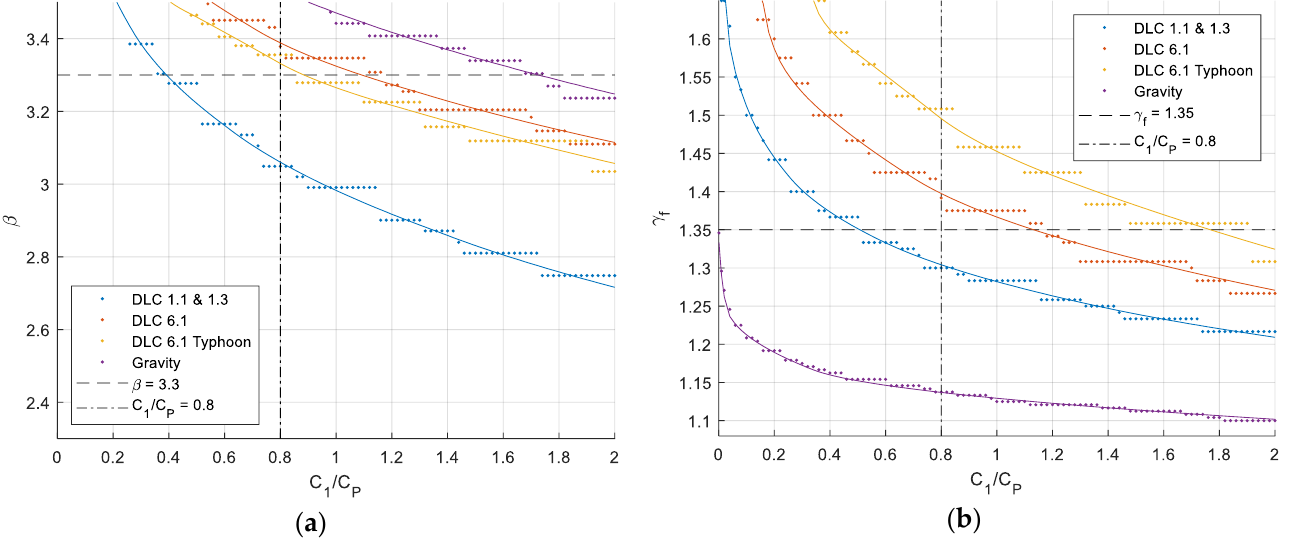
Figure 5. The optimal value of ( a ) annual reliability index (in the first year), ( b ) load safety factor for H / C 1 = 10. The dots correspond to optimal values of the design parameter among the ones where reliability analyses were performed, and the lines are obtained by using a cubic smoothing spline on the expected profit Z(z) and then finding the optimal on that spline.